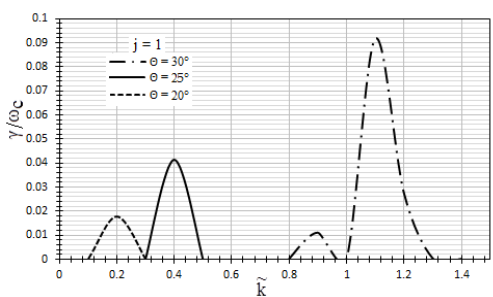
Fig.4: Variation of Growth Rate with respect to various values of θ at other plasma parameters being B o = 80nT, K B T || =400eV, n o =1x10 6 m -3 and